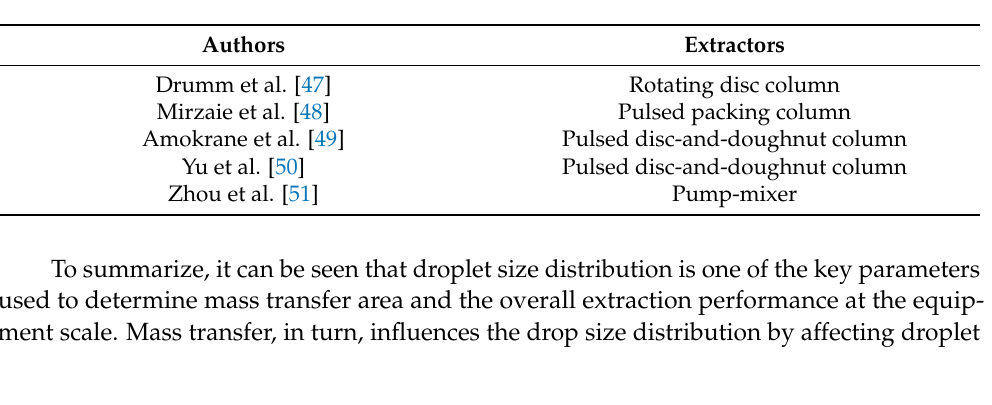
Figure 2. Comparison of droplet size distributions between augmented PBM and original PBM. Reprinted with permission from Ref. [46]. 2020, ACS (American Chemical Society).